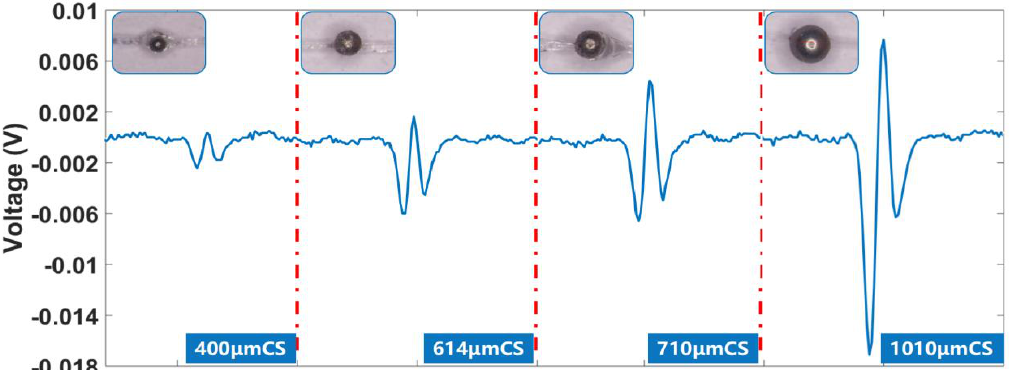
Figure 10. Inductive electric potential generated by carbon steel particles of different particle sizes.